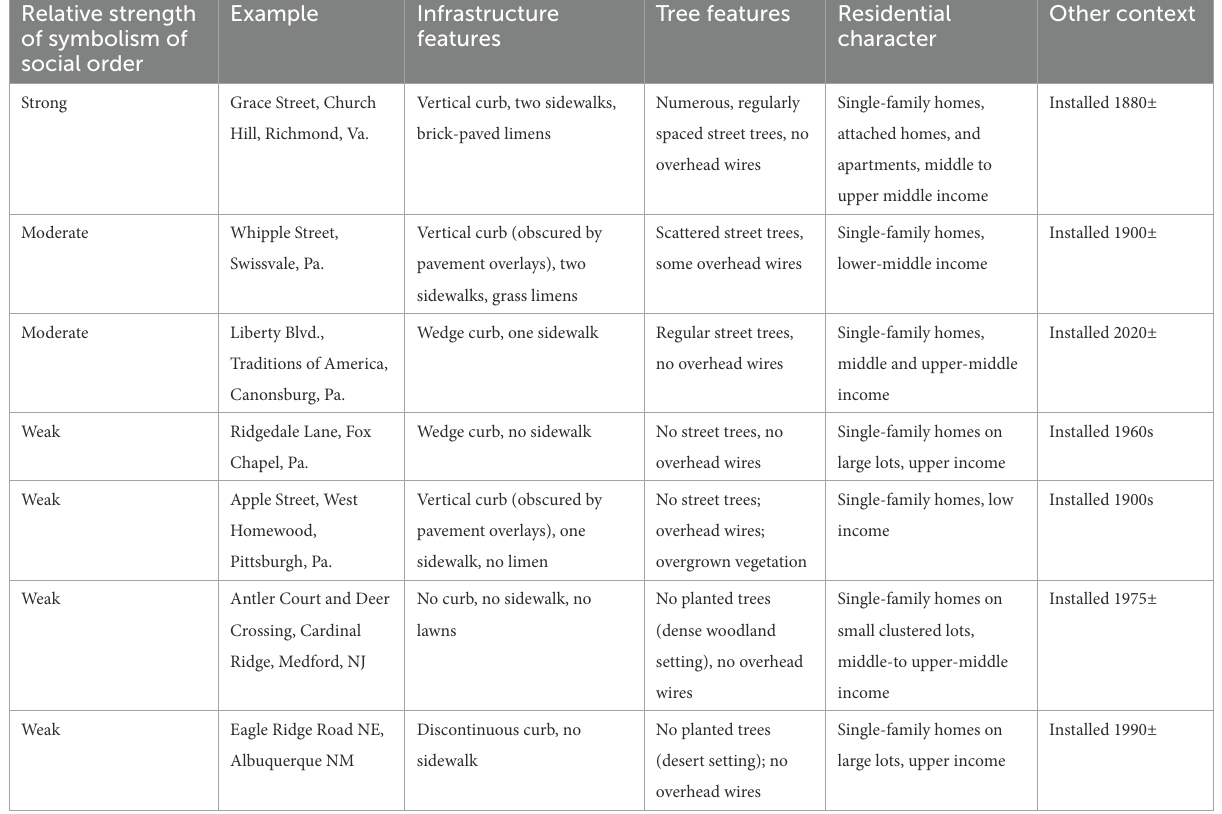
TABLE 1 Features of selected streets with different levels of symbolic social order. Relative strength of symbolism